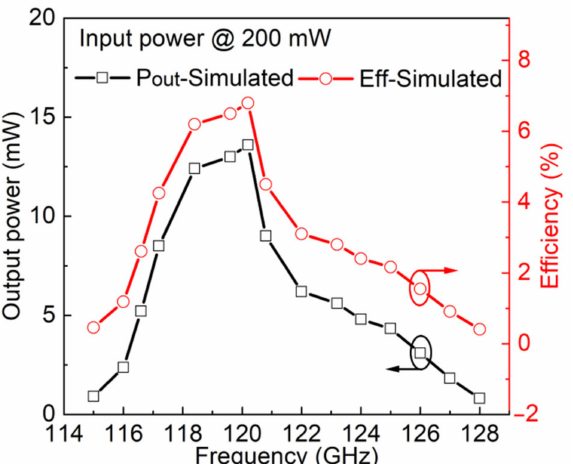
Figure 6. Simulated output power and efficiency of 120 GHz frequency doubler at input power of 200